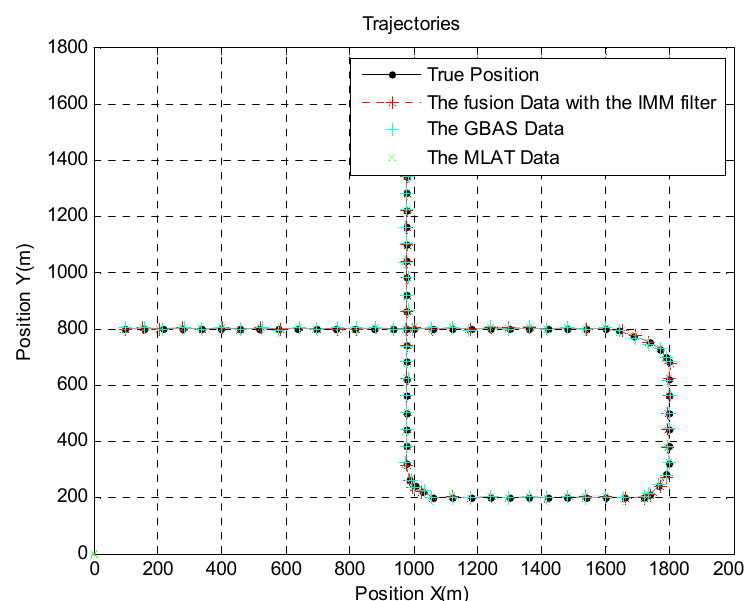
Figure 4. Aircraft trajectory near the